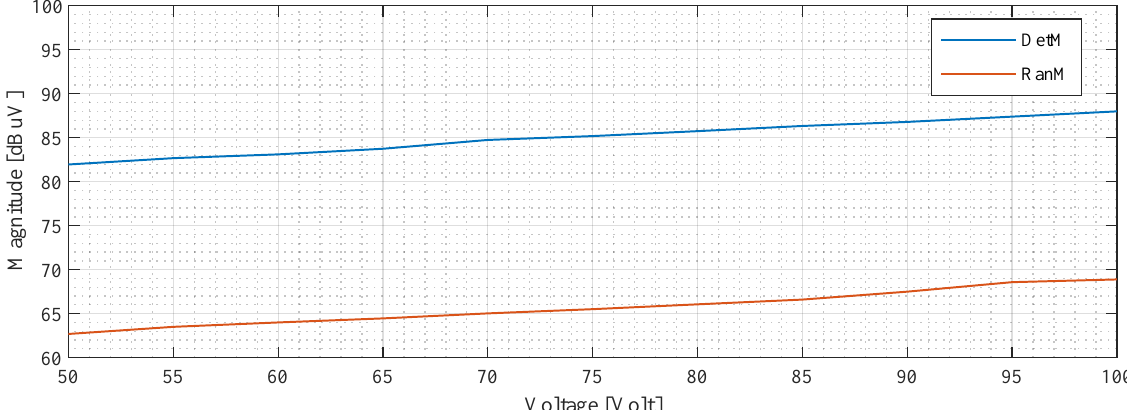
Figure 11. The maximum amplitude of disturbances, measured at the grid terminal (point 1, Figure 3) depending on the converter supply voltage for different modulation schemes (DetM and Ran) for IFBW = 200 Hz.